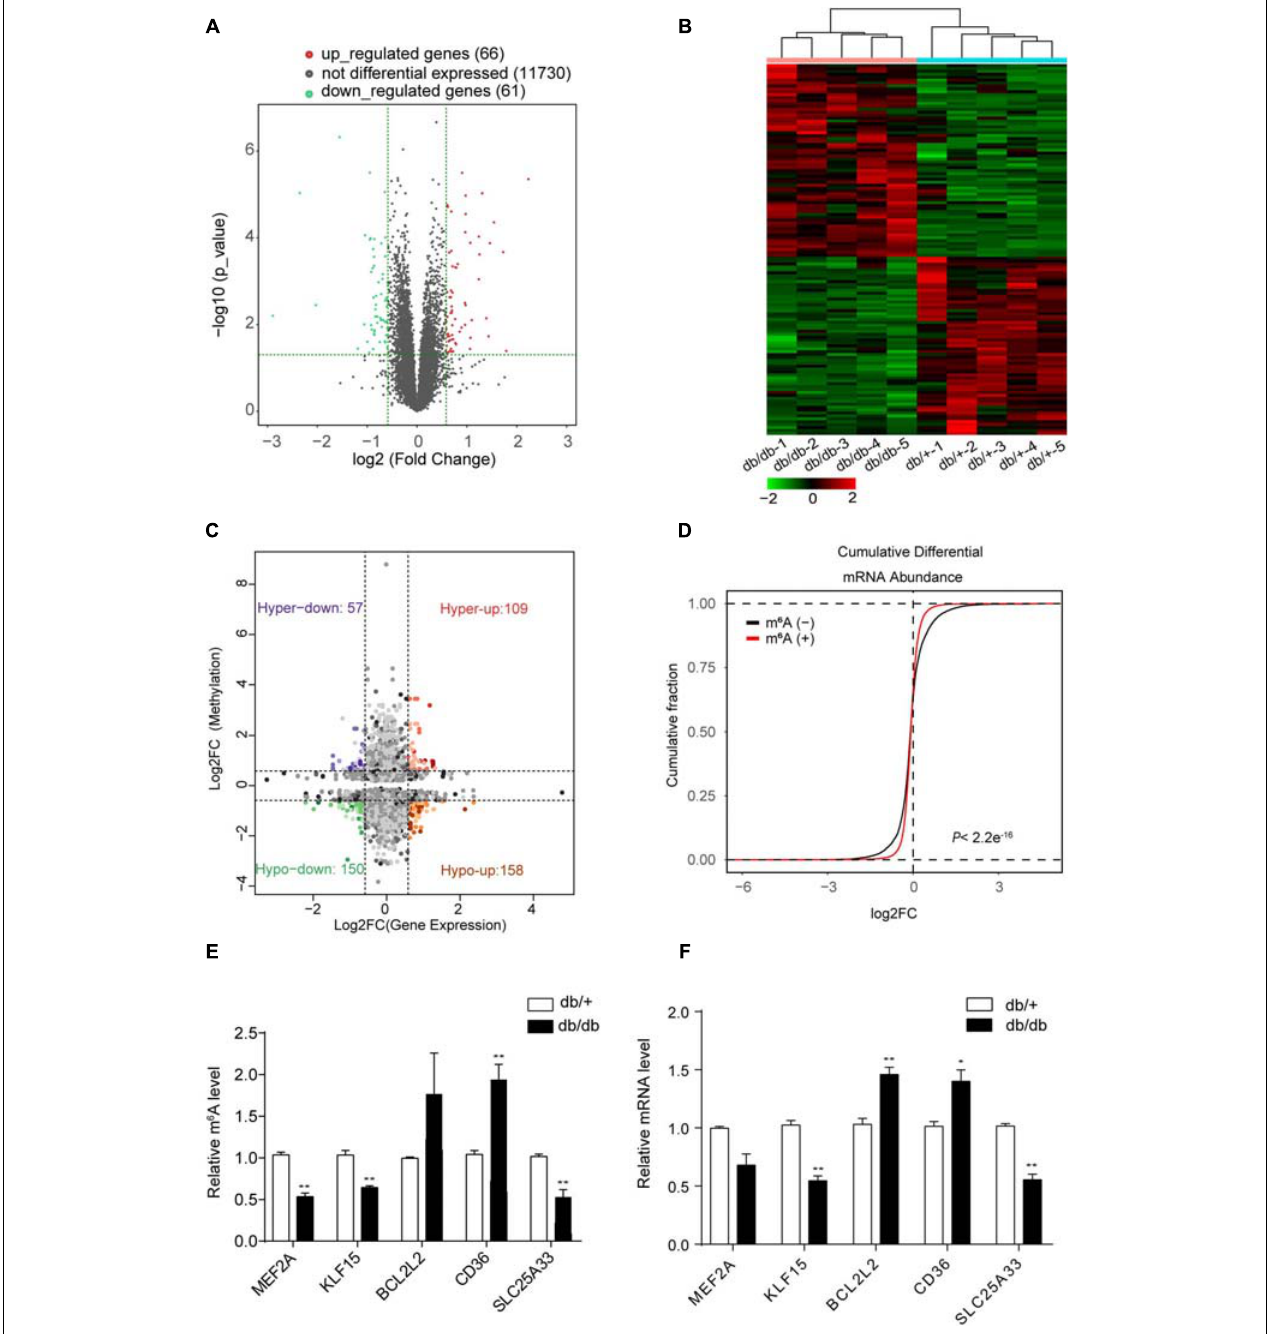
FIGURE 4 | Combined analysis of RNA-seq and MeRIP data comparing DCM and NC samples. (A) Volcano plots showing mRNAs significantly differentially expressed in comparisons between DCM and NC samples (fold-change > 1.5 and P < 0.05). (B) Cardiac clustering analysis of differentially expressed mRNAs ( P < 0.01). (C) Four quadrant graph showing the distribution of transcripts with significant changes in m 6 A-modification level and corresponding mRNA expression (fold-change > 1.2 and P < 0.05). (D) Cumulative distribution of mRNA expression changes between DCM and NC samples for m 6 A-modified genes (red) and non-target genes (black). P values were calculated by two-sample Kolmogorov-Smirnov test. (E) MeRIP-qPCR validation of m 6 A level changes in five representative hyper-methylated or hypo-methylated genes in NC and DCM group samples. (F) Relative mRNA levels of five representative genes were measured by real-time PCR in normal control and DCM group samples. Data are expressed as mean ± SD; data were analyzed using the Student’s t -test. * P < 0.05; ** P < 0.01 vs. NC group ( n = 3 per group).